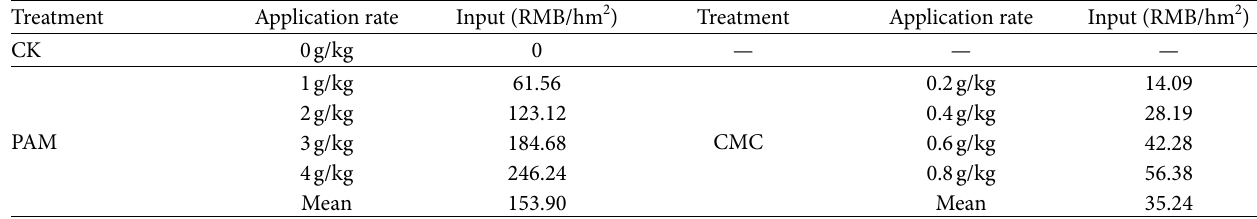
Table 3: Influence of PAM and CMC application rates on economic